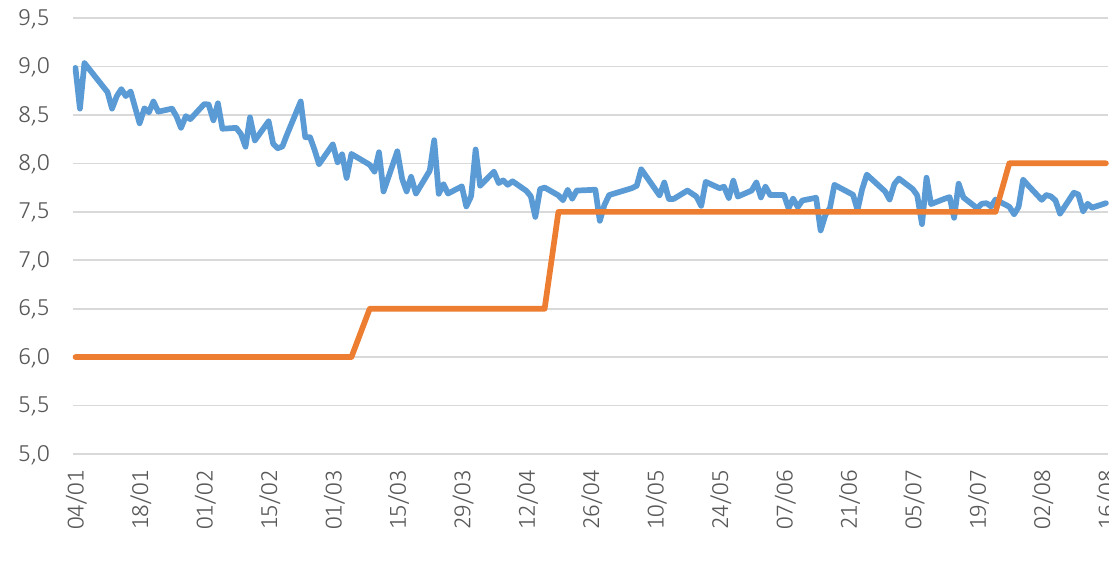
6,57,07,58,08,59,09,5 6,0 5,05,5 0118 0101 0215 0201 0315 0329 0312 0426 0410 0524 0507 0621 0605 0719 0702 0816 08 / / / / / / / / / / / / / / / / 04 / Interest rate on time deposits of individuals in national currency NBU key policy Figure 3. NBU key policy rate and interest rates on deposits, % per annum